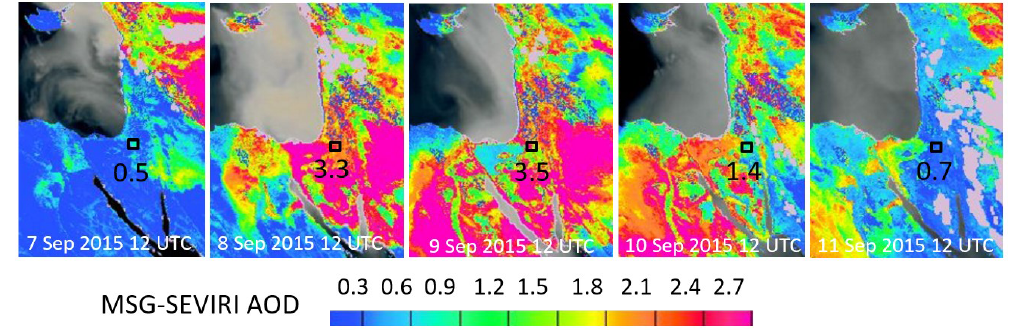
Figure 15. AOD at 12:00UTC on 7–11 September 2015 analyzed by NASCube (Université de Lille) based on imagery from the MSG- SEVIRI satellite (by a combination of SEVIRI channels IR8.7, IR10.8 and IR12.0). The map includes indication of the Sde Boker AERONET site (black square) and its AOD value at 12:00UTC.